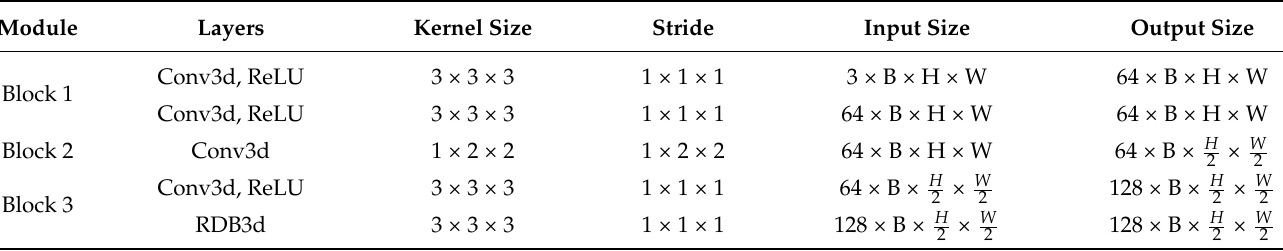
Table 1. Network configuration of the